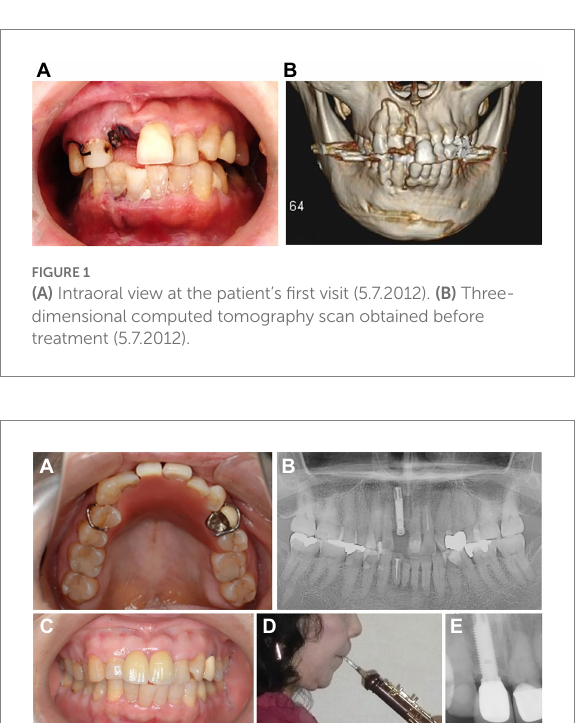
FIGURE 2 (A) Occlusal view with the removable prosthesis placed (19.7.2012). (B) Panoramic radiograph with the dental implant inserted (19.7.2012). (C) Intraoral view with the final prosthesis in place (7.3.2013). (D) Lateral view of the patient with the oboe in place (7.3.2013). (E) Dental radiograph after 8 years observation